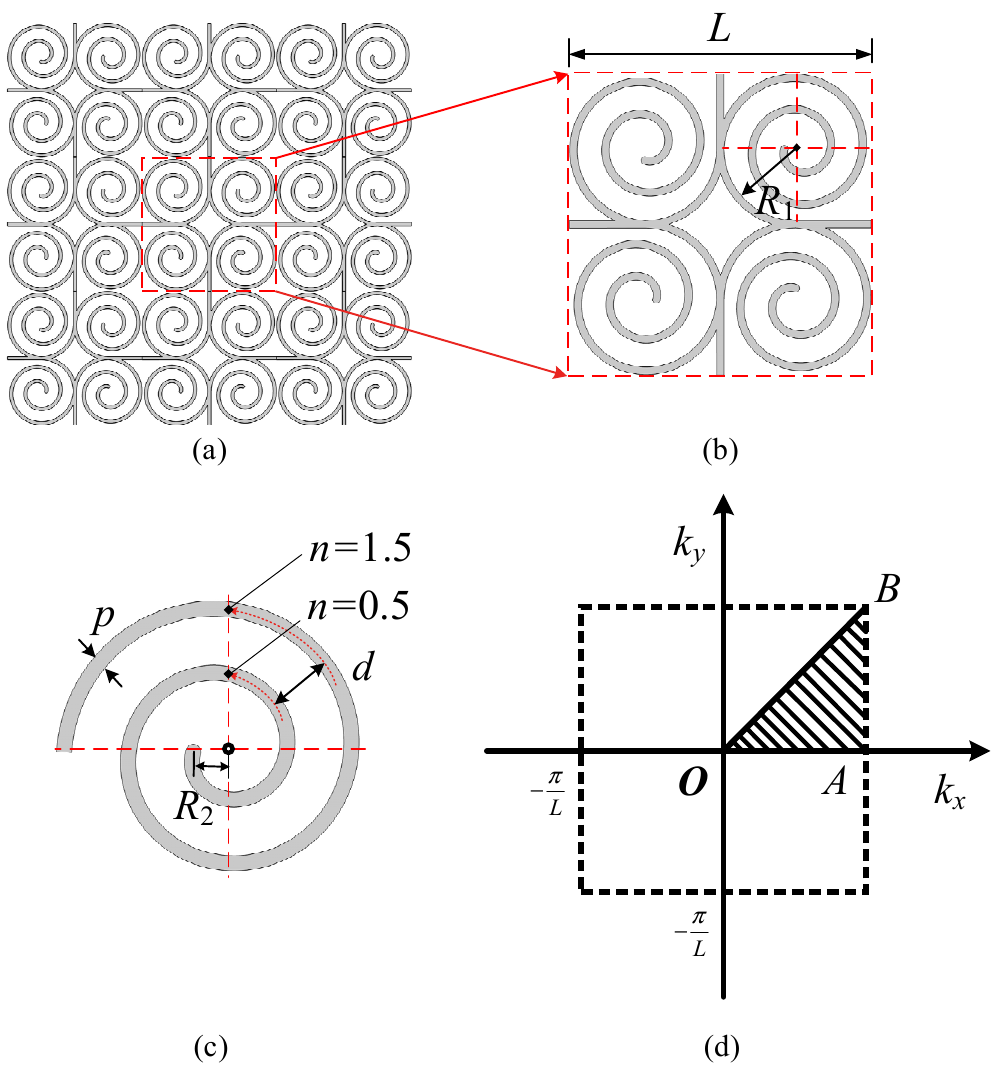
Figure 1. ( a ) Description of the square honeycomb acoustic metamaterials with locally resonant Archimedean spirals (SHAMLRAS); ( b ) the unit cell of SHAMLRAS; ( c ) the circular array unit of Archimedes spiral; ( d ) the first Brillouin zone and irreducible Brillouin zone (IBZ, black shadow region). The spiral line control equation is derived from the Archimedean spiral line and is derived as follows: where θ is the pole angle, α is the pole diameter when θ = 0, i.e., the initial radius, and β is the increase (or decrease) of the pole diameter per 1 rad of